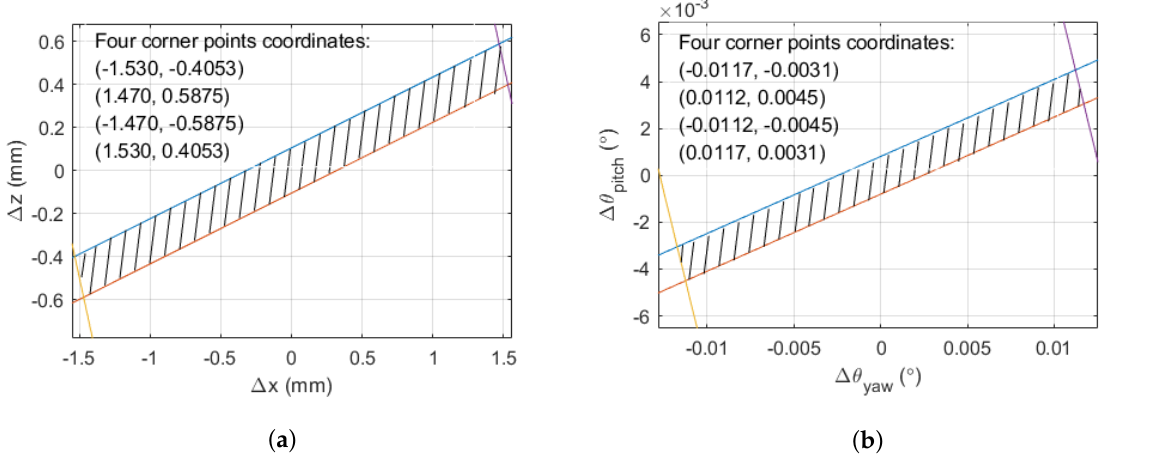
Figure 3. Under the condition that the accuracy of radial velocity measurement is 0.1 m/s and the beam code is 162, the allowable range of antenna phase center position error and attitude error is obtained. ( a ) Allowable antenna phase center position error range: the values of ∆ x and ∆ z must be located in the area of diagonal line in the figure. ( b ) The allowable range of attitude error without considering squint angle: the values of ∆ θ yaw and ∆ θ pitch must be located in the area where the oblique line is drawn in the